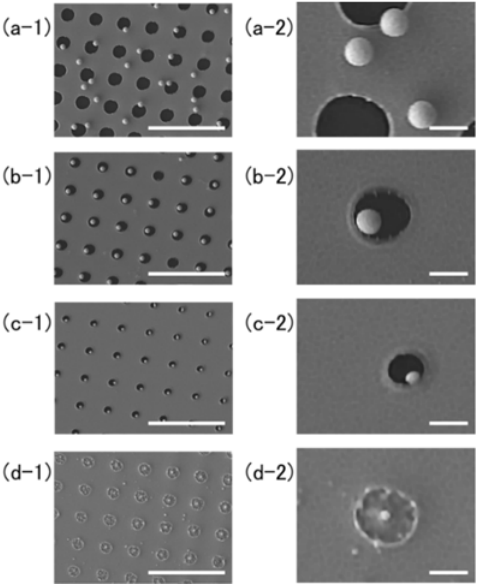
Figure 2. Scanning electron microscopy (SEM) images of the target surface with different film thickness. ( a ‐ 1 ) 40 nm; ( b ‐ 1 ) 50 nm; ( c ‐ 1 ) 60 nm; and ( d ‐ 1 ) 100 nm, and their magnified images on right column: ( a ‐ 2 ) 40 nm; ( b ‐ 2 ) 50 nm; ( c ‐ 2 ) 60 nm; and ( d ‐ 2 ) 100 nm. The experimental parameters and results are summarized in Table 1. The white bars in the images on the left and right columns represent 5 µ m and 500 nm, respectively.